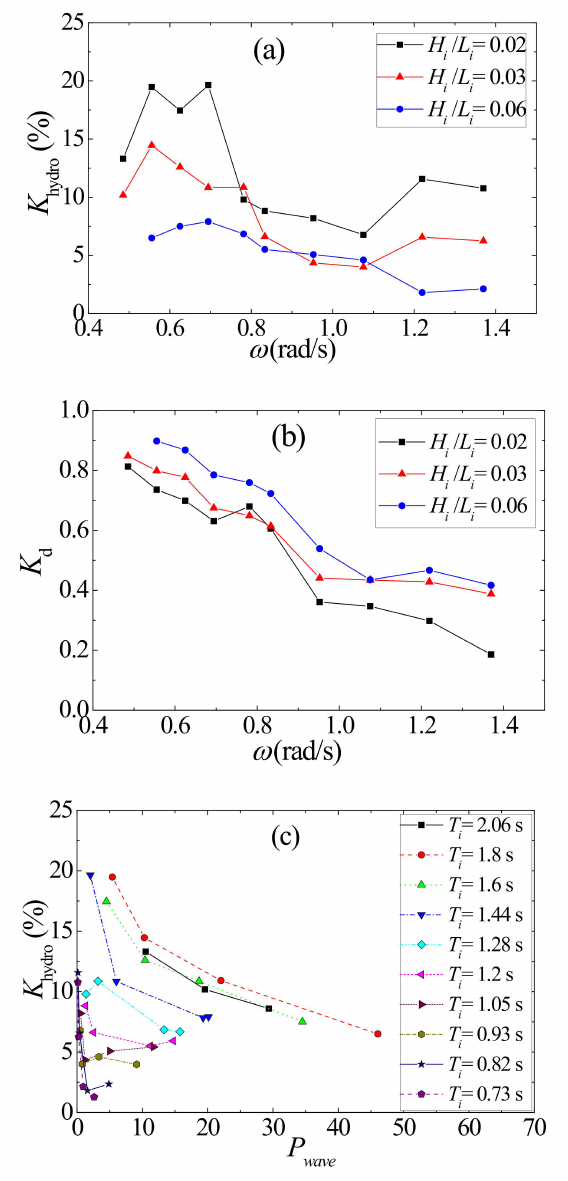
Figure 14. Variations of hydrodynamic e ffi ciency and dissipation coe ffi cient as functions of wave frequency and incident wave power: ( a ) e ff ect of wave frequency on hydrodynamic e ffi ciency; ( b ) e ff ect of wave frequency on energy dissipation coe ffi cient; ( c ) e ff ect of incident wave power on hydrodynamic e ffi